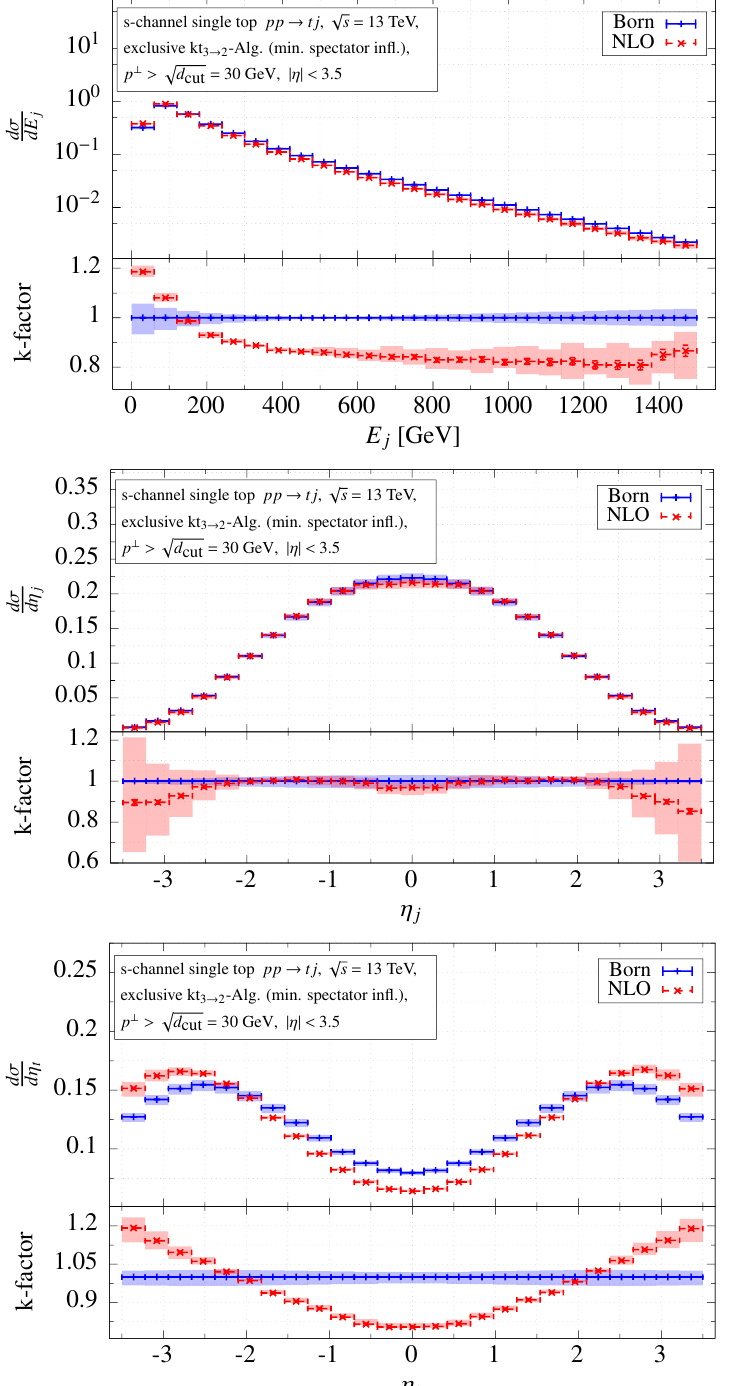
Figure 27 . Unnormalised distributions and k-factors for s -channel single top-quark production using the exclusive event